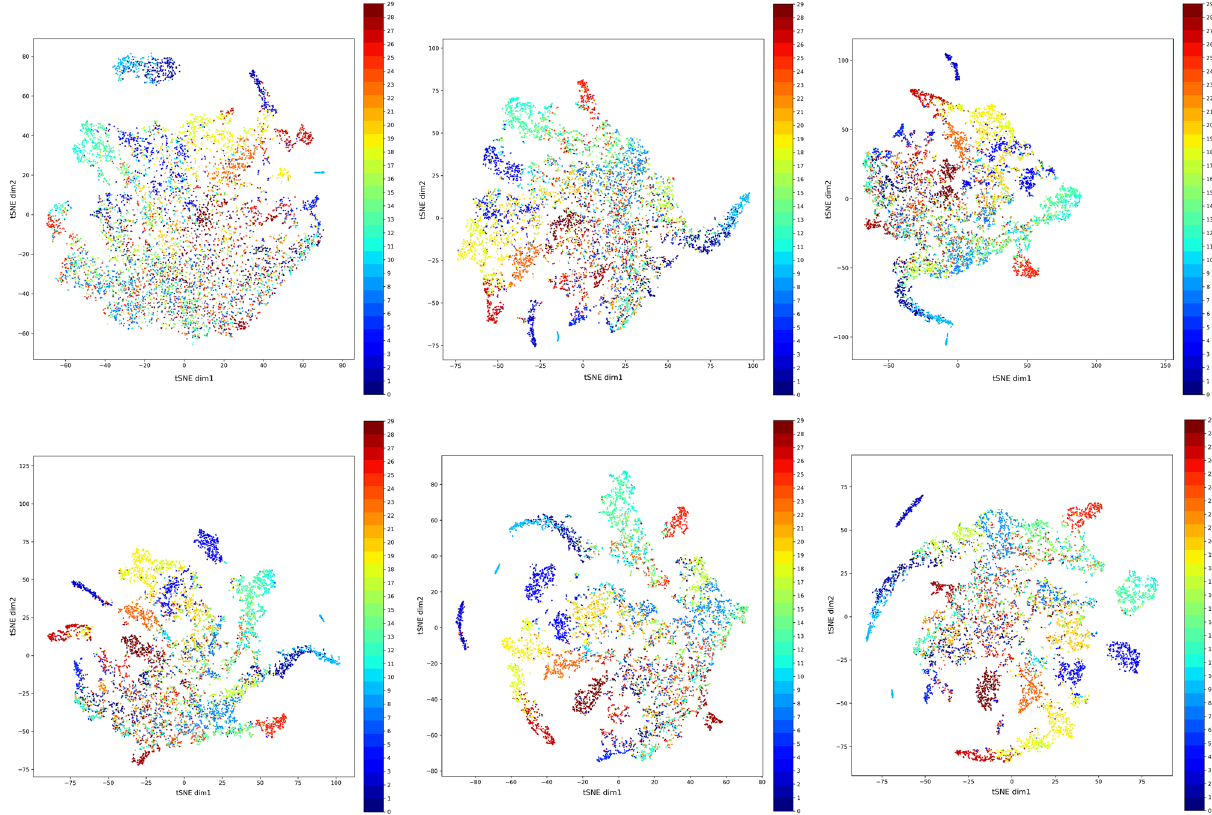
Figure 4. tSNE plots for the unlabeled set of the AID dataset throughout the training process. The number of epochs is 300 and plots are saved every 50th